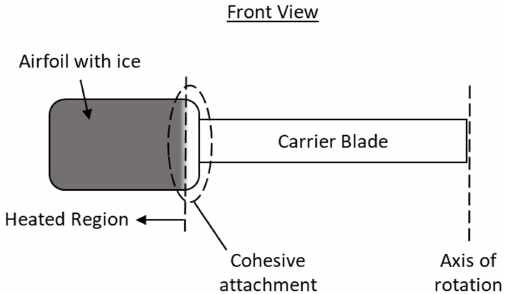
Figure 17. Photograph of the ice removal